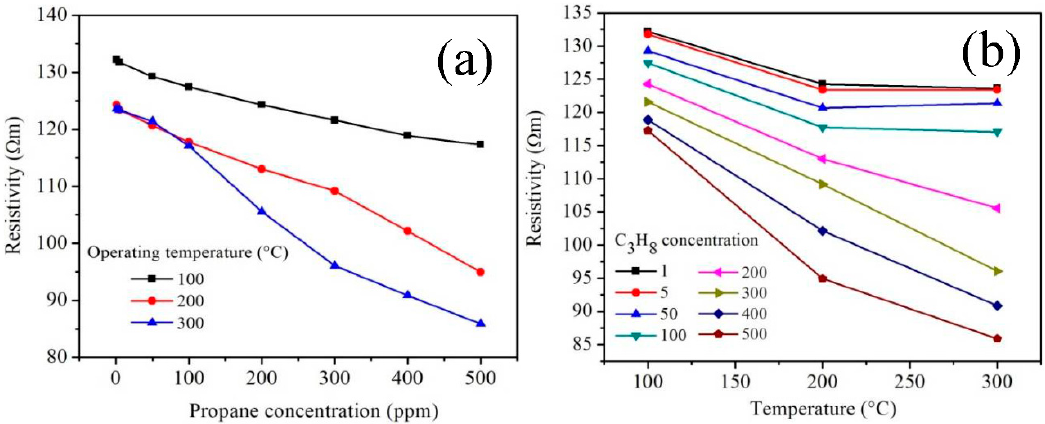
Figure 13. Electrical resistivity of the MnSb 2 O 6 pellets as a function of ( a ) propane concentration and ( b ) operating temperature.